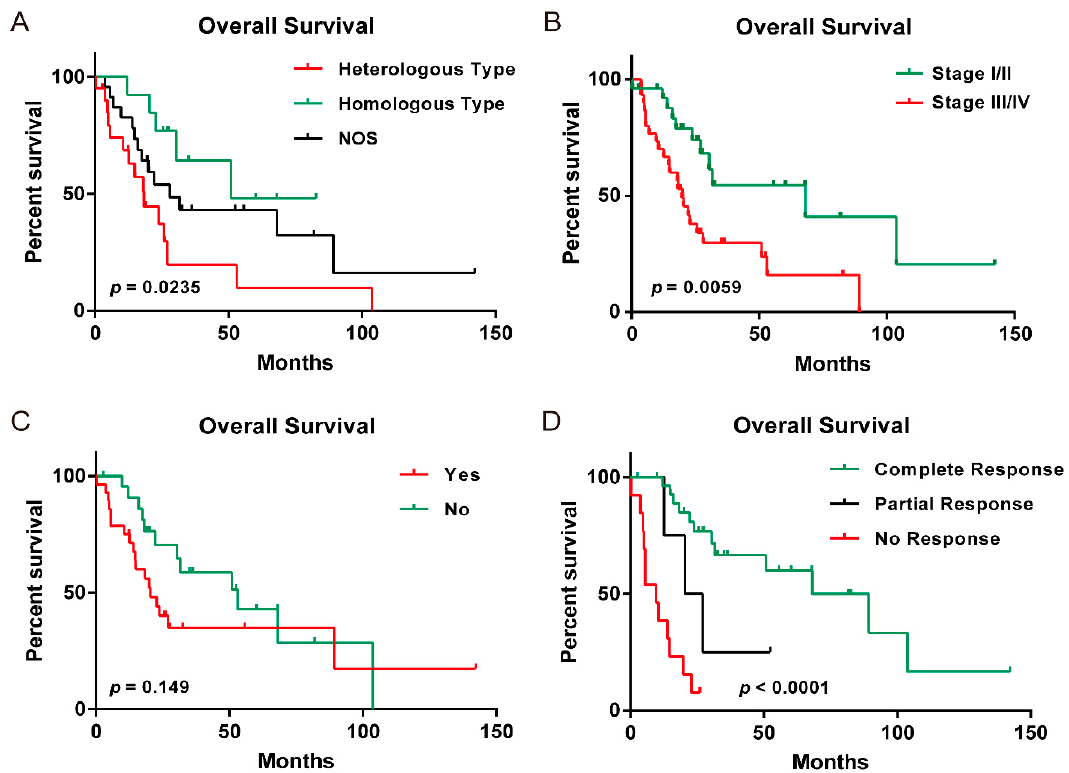
Figure 2. Survival analysis (overall survival, OS) of clinicopathologic characteristic of uterine carcinosarcoma (UCS) patients in OSucs. ( A ) Histological type, ( B ) clinical stage, ( C ) hypertension, ( D ) therapy outcome.